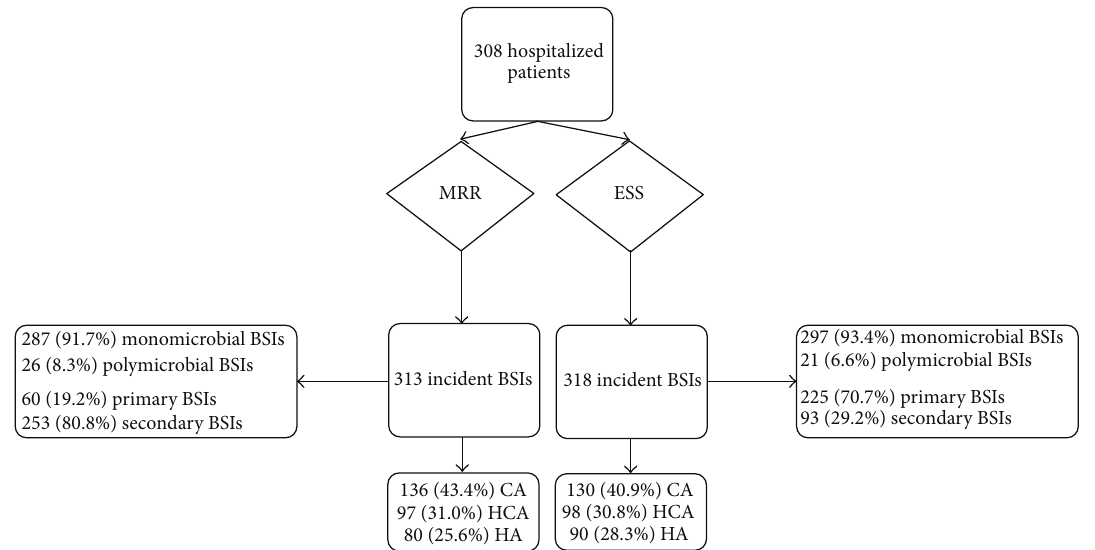
Figure 1: Distribution of incident bloodstream infections in the medical record review and the electronic surveillance system. HA: hospital- acquired; HCA: healthcare-associated community-onset; CA: